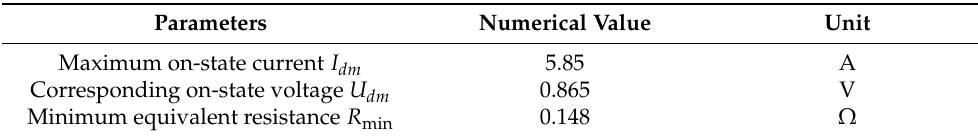
Figure 7. The forward conduction current–voltage curve of the 10A10MIC rectifier diode. Based on the forward conduction current–voltage curve of the diode in Figure 7, the parameters in Equation (27) are selected and calculated, as shown in Table 3. Table 3. The on-state voltage and equivalent resistance of the diode corresponding to the maximum on-state